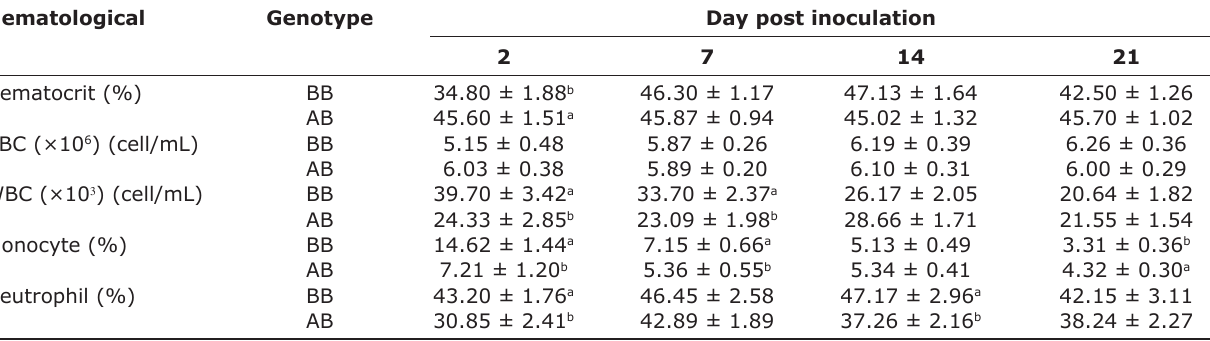
Table-3: Effects of intron 6 of Nramp1 gene on the hematological trait in pigs (Least square means ± standard errors). Hematological